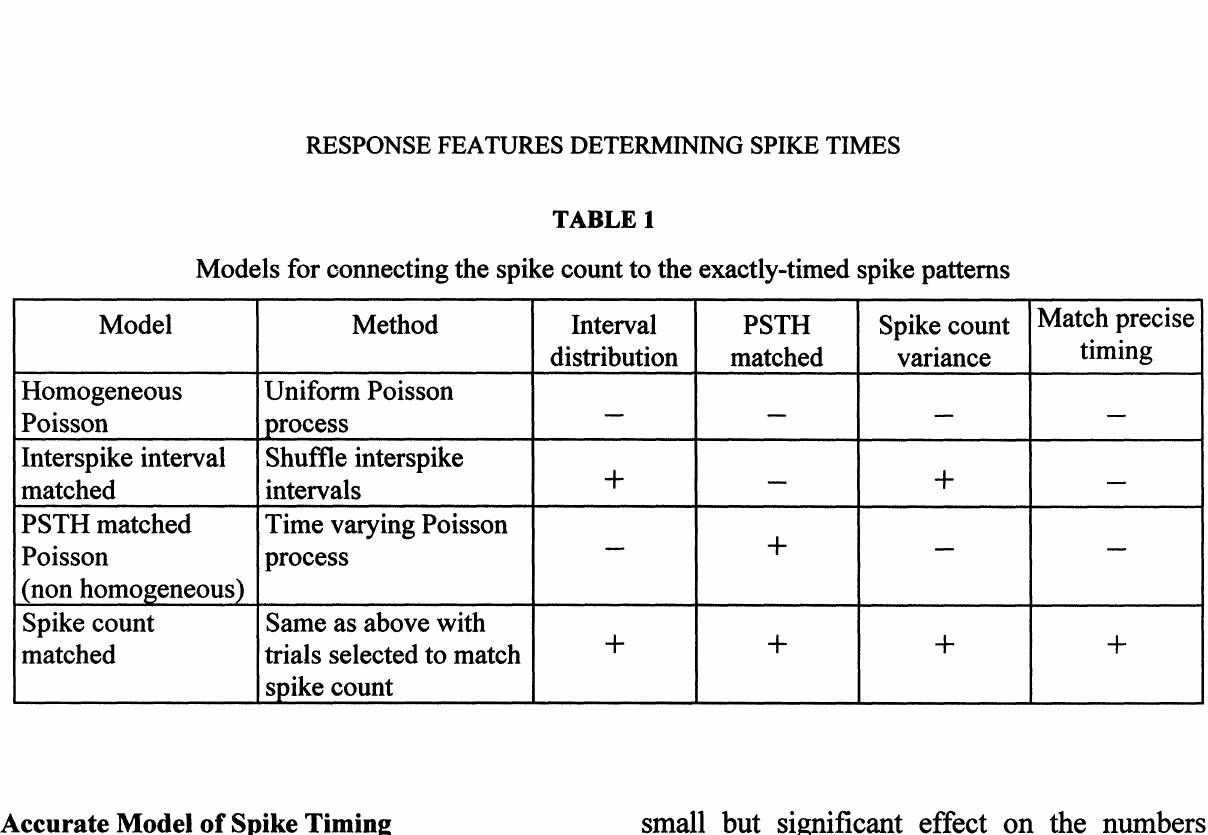
small but significant effect on the numbers of repeating triplets. For example, in V 1 the number of repeating triplets averaged 0.57; the predictions were 0.45 for the NHPP model, 0.55 for the spike count matched model, and 0.57 for the spike count matched model with the ISI’s adjusted. For the data presented here, only the first two intervals must be adjusted.